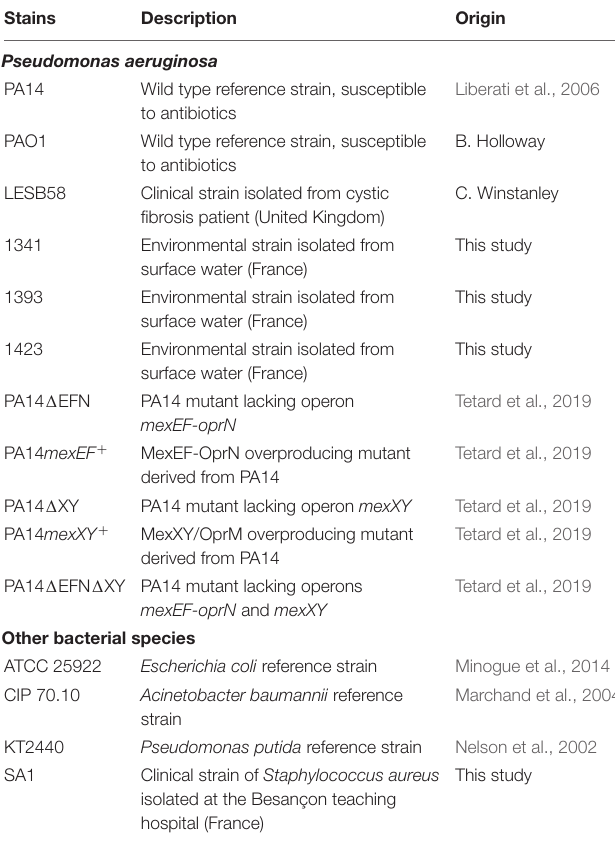
TABLE 3 | Strains and plasmids used in the